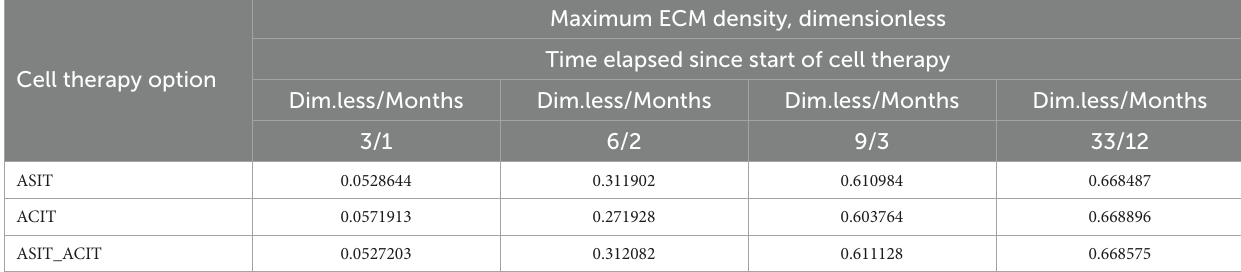
TABLE 1 Maximum values of ECM density at different time points with different options of cell therapy.